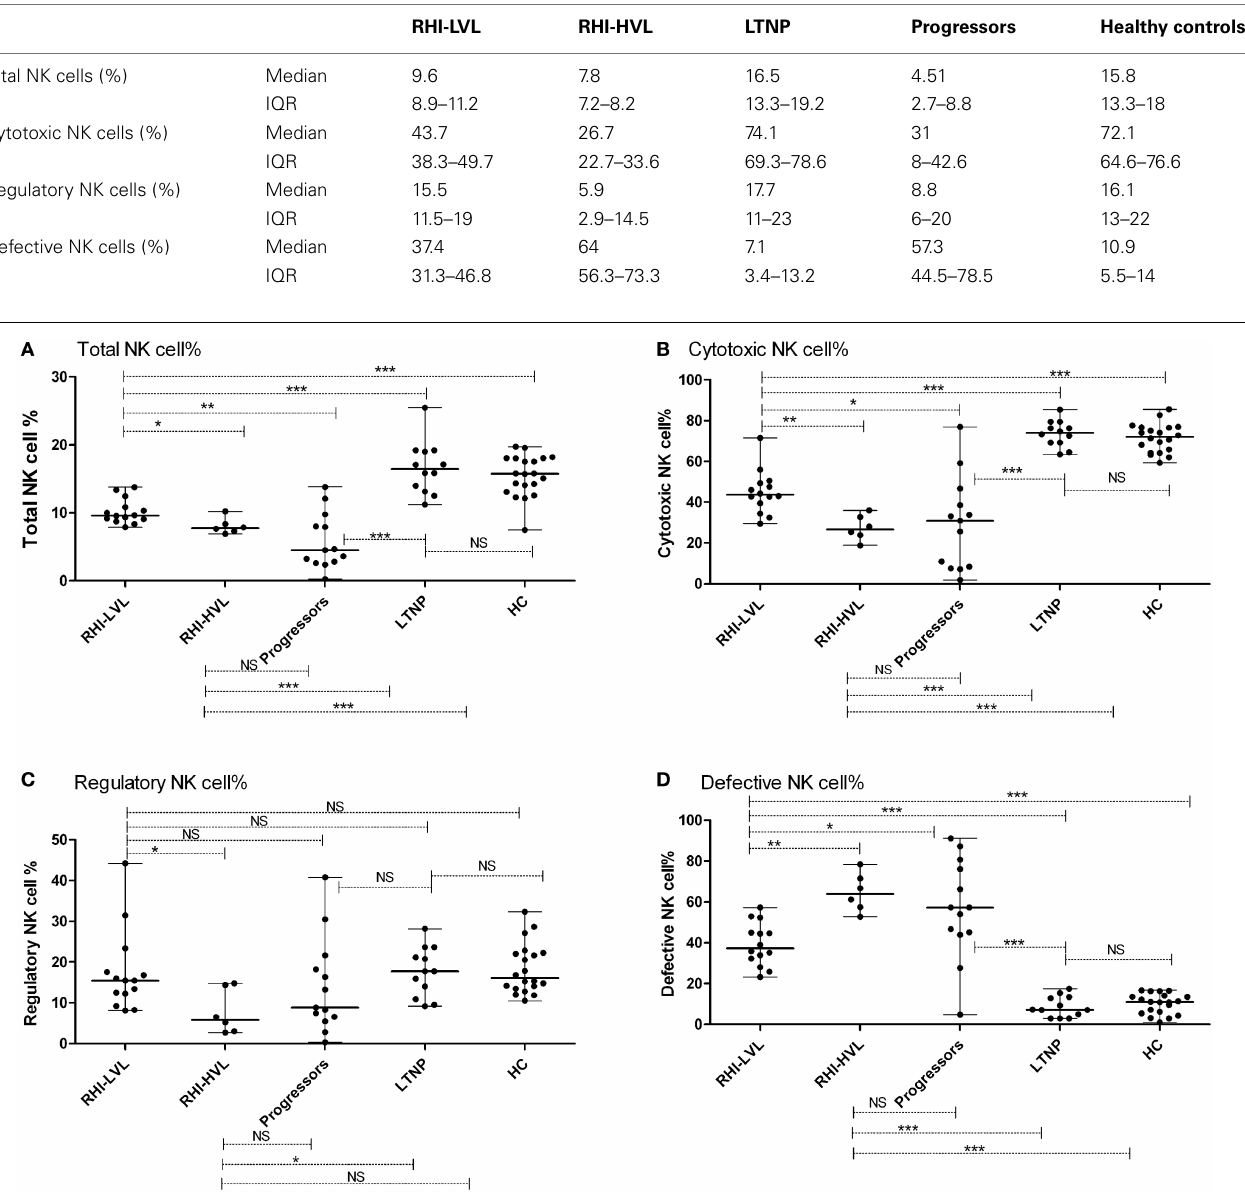
Table 2 | Frequency of NK cells and subset wise distribution .